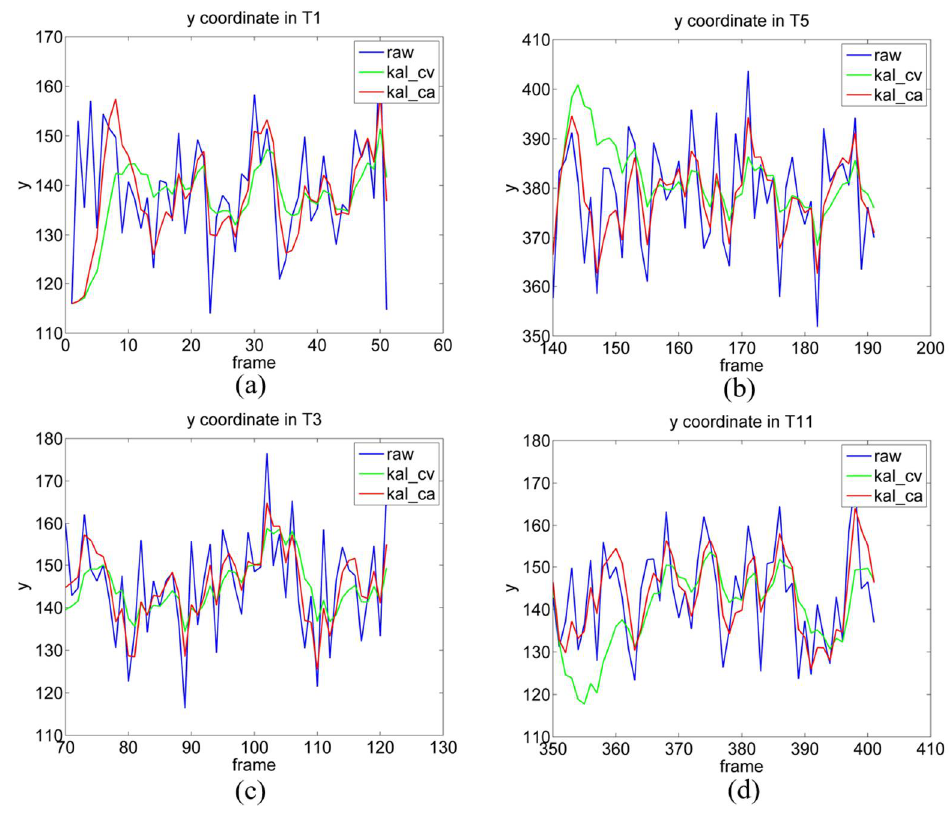
Figure 13. y-values in T1, T5, T3, and T11. ( a ), ( b ) ( c ) and ( d ) are the y-values of period T1, T5, T3 and T11, respectively.